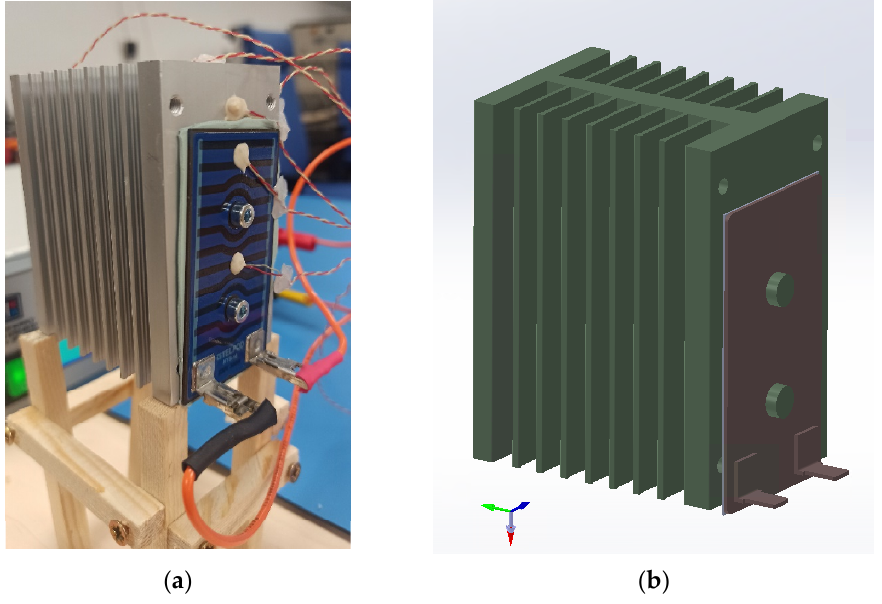
Figure 7. ( a ) Measurement of Setup 4; ( b ) Simulated model of Setup 4 and gravity orientation.